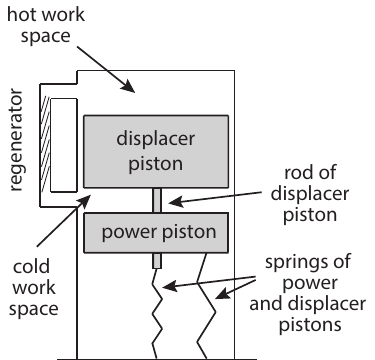
Figure A5. Schematic of a FPSE (modified from